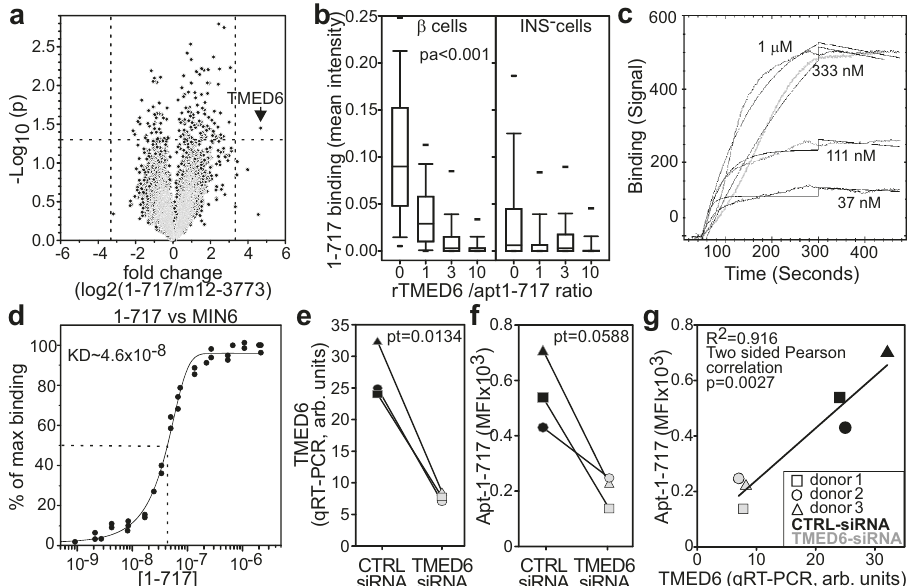
Fig. 4 TMED6 is the putative target for aptamer 1-717. a Vulcano plot of aptamer 1-717 over m12-3773 binding on protein arrays Two sides paired T test was performed. b Cold target inhibition assay. cy3-labeled aptamer 1-717 was admixed at different molar ratios with unlabeled recombinant TMED6. The mixture was then used as a probe against a section of human pancreata. Sections were counterstained with anti-insulin antibody and DAPI; images were acquired and processed with Cell Pro fi ler. Data derived from two independent experiments evaluating 450, 528, 449, and 491 INS + cells and 2590, 3063, 2875, and 2775 cells INS - cells for 0, 1, 3, and 10 rTMED6/aptamer ratio, respectively. The box plot shows the median, the 25, 75, 10, 90, 5, and 95th percentile. One-way ANOVA followed by Holm – Sidak multiple pairwise comparisons was performed. c Aptamer 1-717 was run at the indicated concentration as analyte against recombinant TMED6 (ligand) in a surface plasmon resonance assay. d Af fi nity. MIN6 cells were stained with vital dye, and different concentration 1-717 aptamer-chimera annealed with cy5-labeled guide saRNA and analyzed by fl ow cytometry. e Human islets (250 IEQ) were treated with siRNA TMED6 aptamer m12-3773 chimera or with siRNA scrambled aptamer m12-3773 chimera and TMED6 expression was assessed by qRT-PCR 72 h later. Two sides paired T test was performed. f Part of the islets from ( e ) were dissociated and labeled with 1-717 aptamer and anti-insulin antibody and analyzed by fl ow cytometry. Two sides paired T test was performed. g Correlation between aptamer 1-717 signal and TMED6 expression. Source data are provided as a Source Data fi